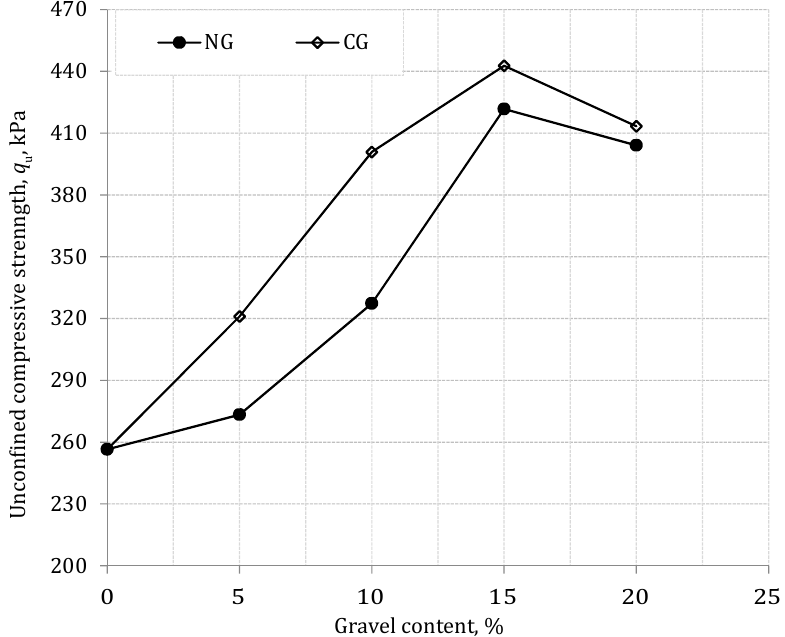
Figure 6. Change in q u for the clay with NG and